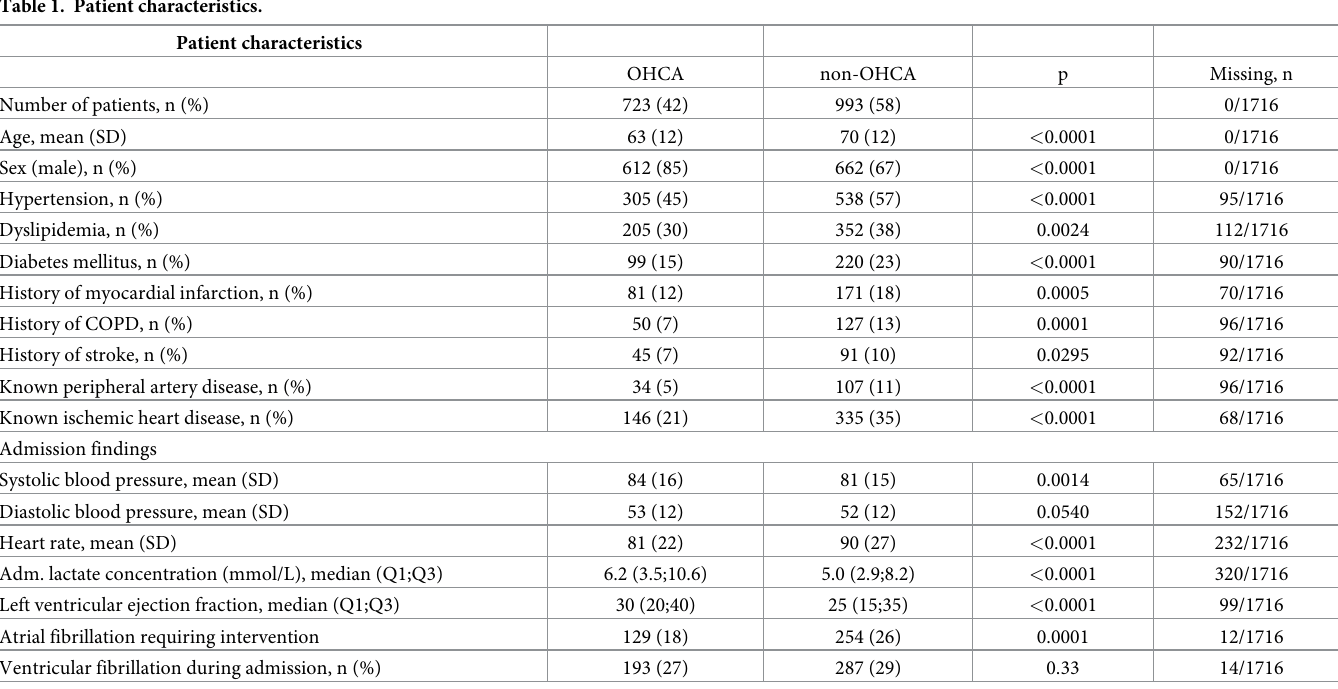
Table 1. Patient characteristics.